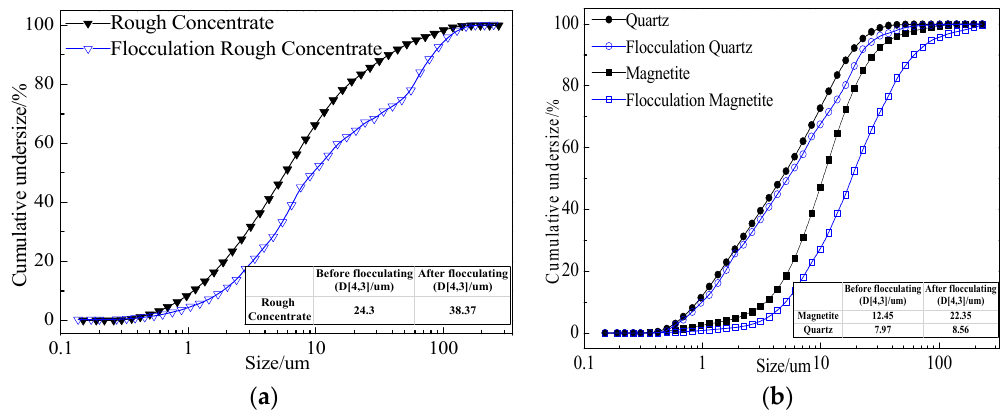
Figure 11. ( a ) The particle size distributions of rough concentrate before and after flocculation; ( b ) The particle size distributions of magnetite and quartz before and after flocculation.